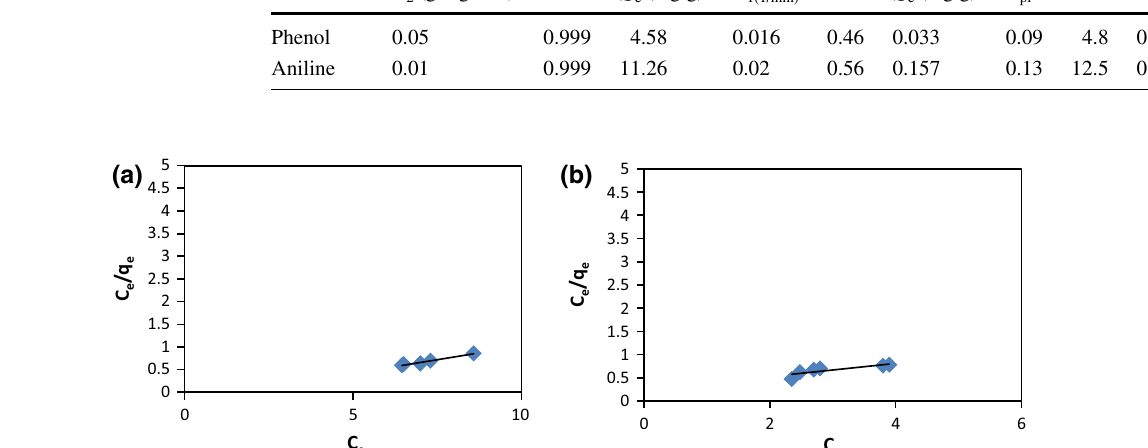
Table 7 The adsorption kinetic model constants for aniline and phenol adsorption